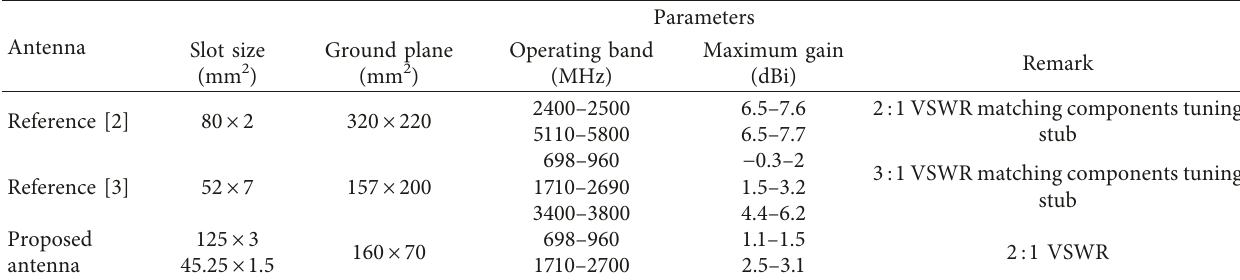
Table 3: Comparison of recently published works and proposed